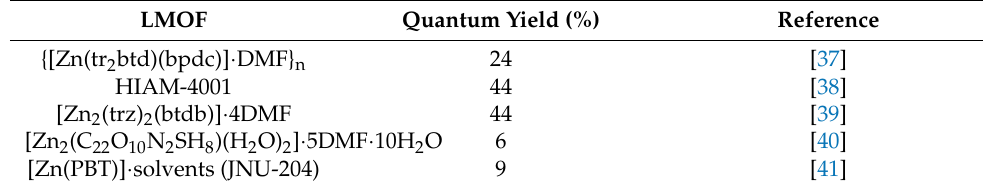
Figure 4. Luminescence intensity of MOF 1 suspension upon addition of different metal cations (C = 0.1 mM).